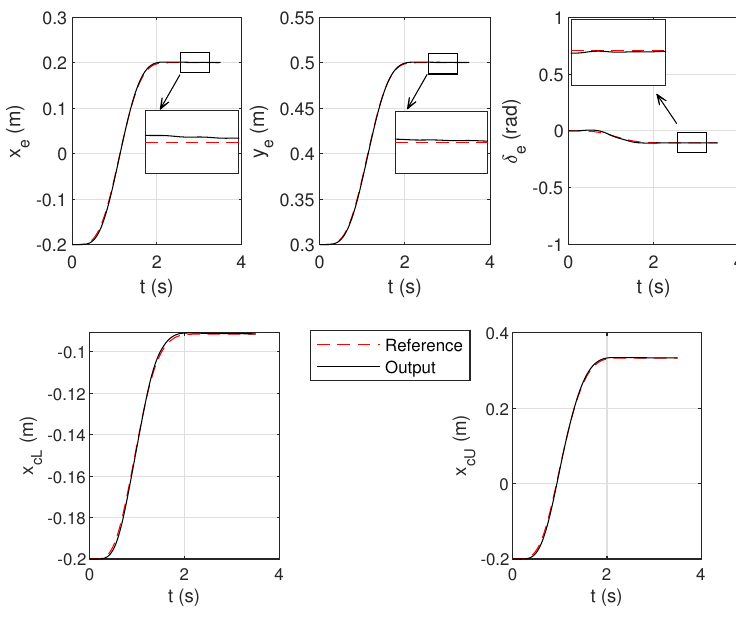
Figure 11. Case III results.